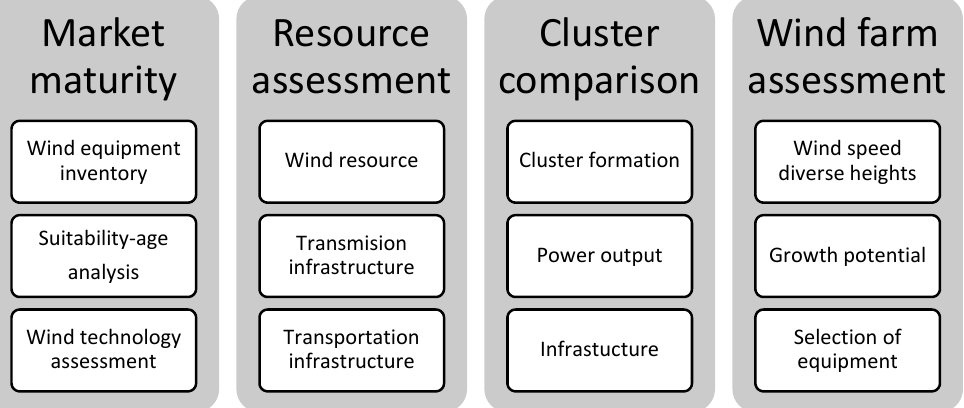
Figure 1. Repowering assessment method for mature market application.